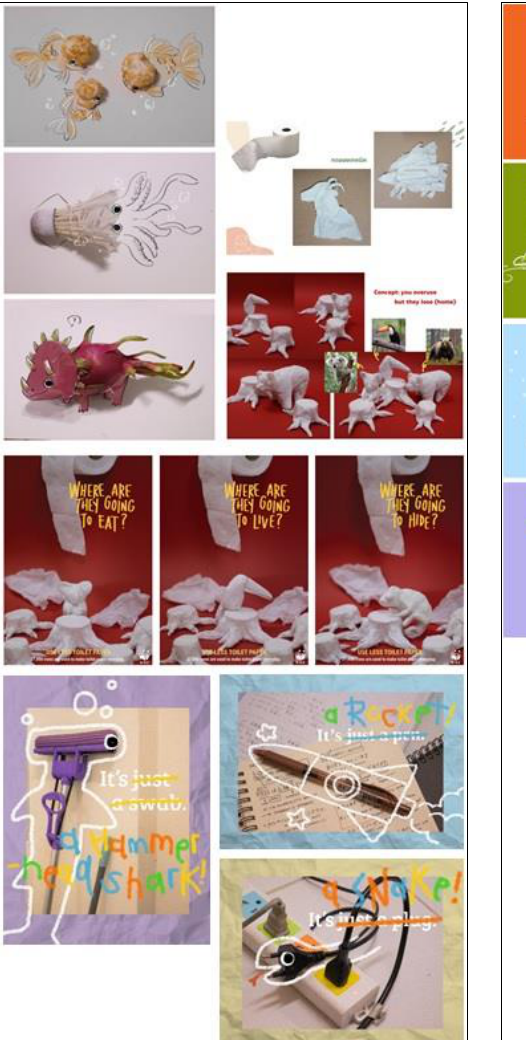
Figure 4. Examples of creative works of the student from the moderate to the strong